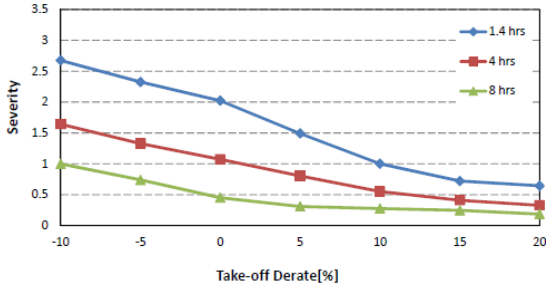
Figure 9: Severity characteristics for variation in take-off derate and flight